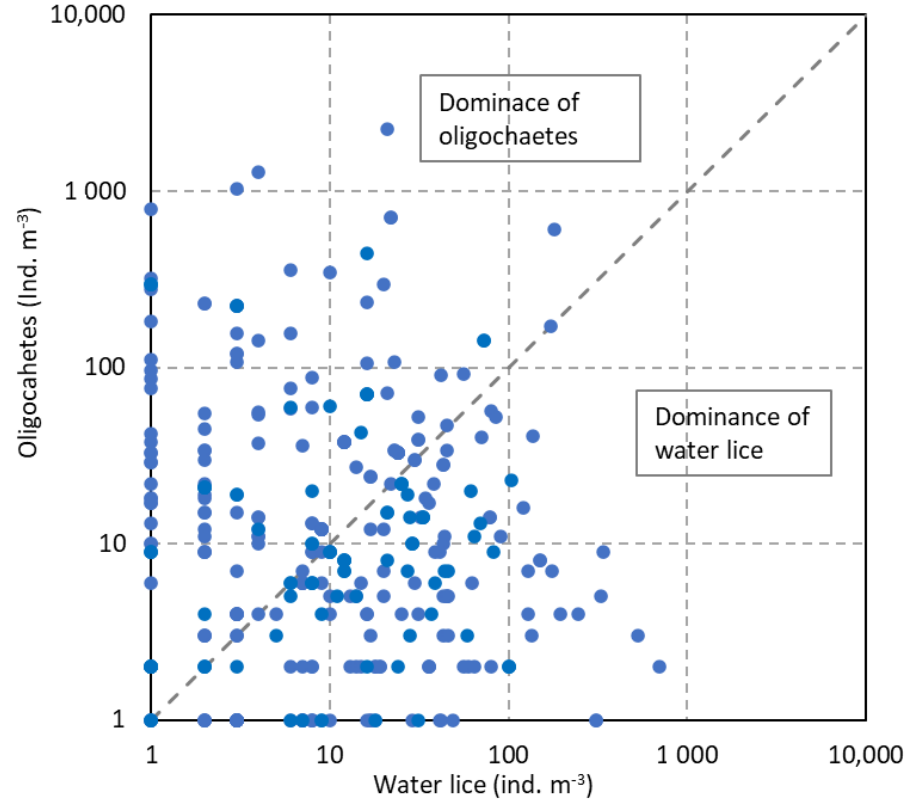
Figure 3. Cont . Figure 3. Test of co-relationship of water lice and oligochaetes in a drinking water network.